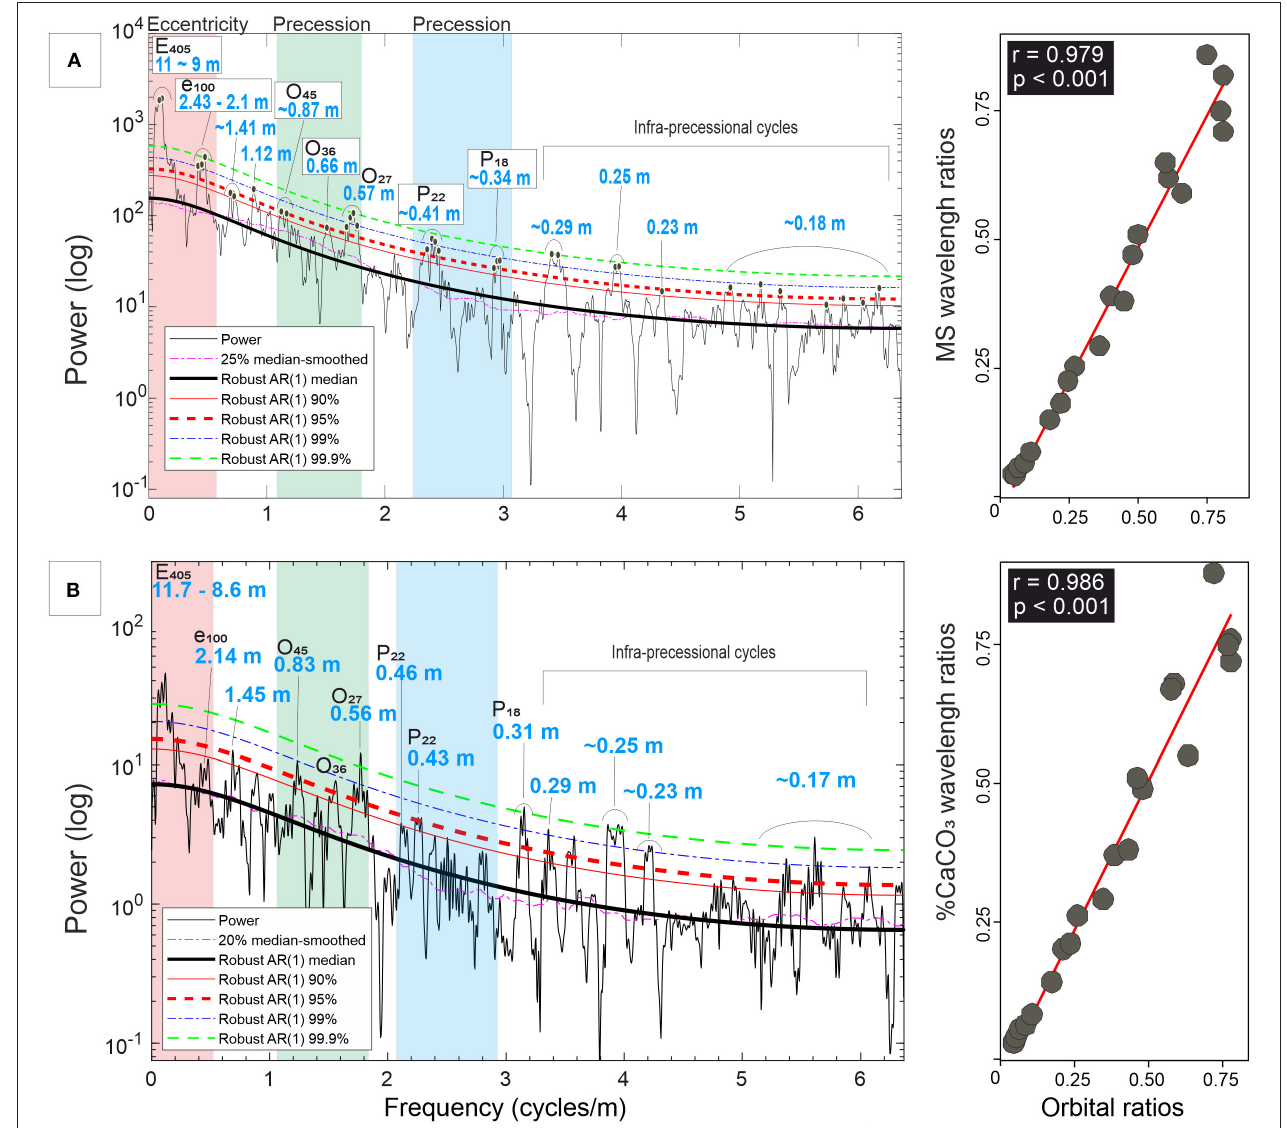
FIGURE 5 | Power spectrum density of the applied 2 π -MTM on the untuned (A) MS series and (B) calcium carbonate content series with the corresponding calculated coefficient of correlation for each used proxy.